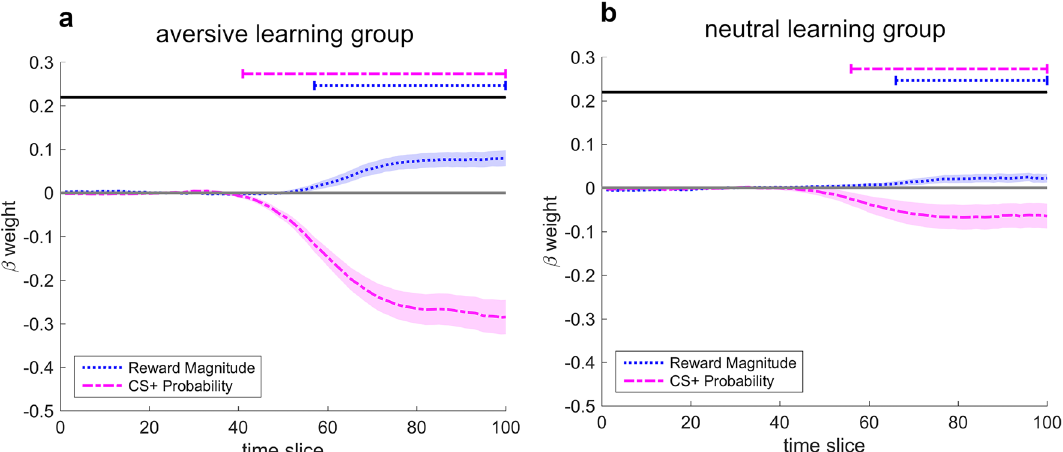
Figure 4. Time-continuous beta weights from TCMR analysis in ( a ) the aversive learning group and ( b ) the neutral learning group for the predictors Reward Magnitude and CS+ Probability. Positive β weights indicate movement tendencies towards the CS+/high reward option, negative β weights indicate tendencies towards the CS−/low reward option. Horizontal lines at the top indicate segments of significant impact. Shaded areas represent standard error of the mean. Only segments of more than 10 successive significant t -tests were accepted as meaningful. In the aversive learning group, a time slice corresponds on average to 7.8 ms. In the neutral learning group, a time slice corresponds on average to 7.7